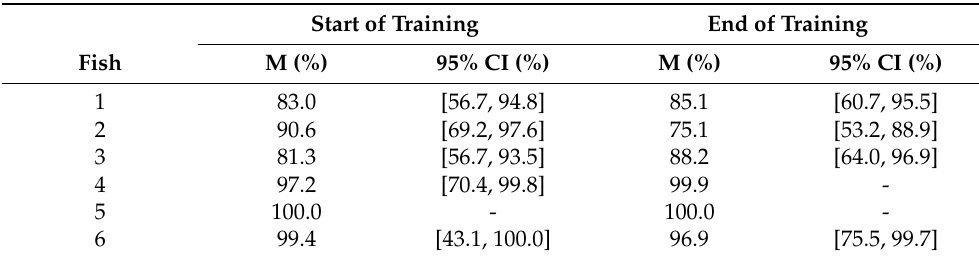
Table 2. Accuracy at the beginning and end of training for all fish. Start of